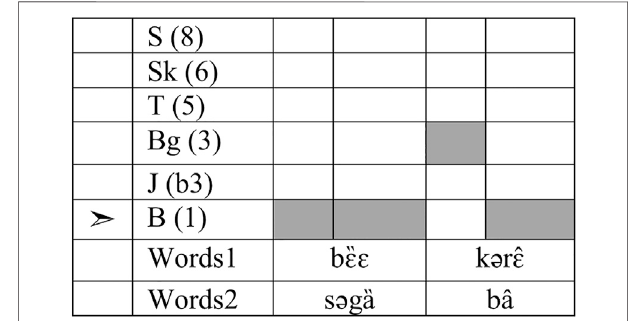
FIGURE 2 | Balafon encoding of “ male pig ” or “ male sheep ” . Arrow by B(a ̂ a- ɲ a ̏ ) indicates the center of the mode.